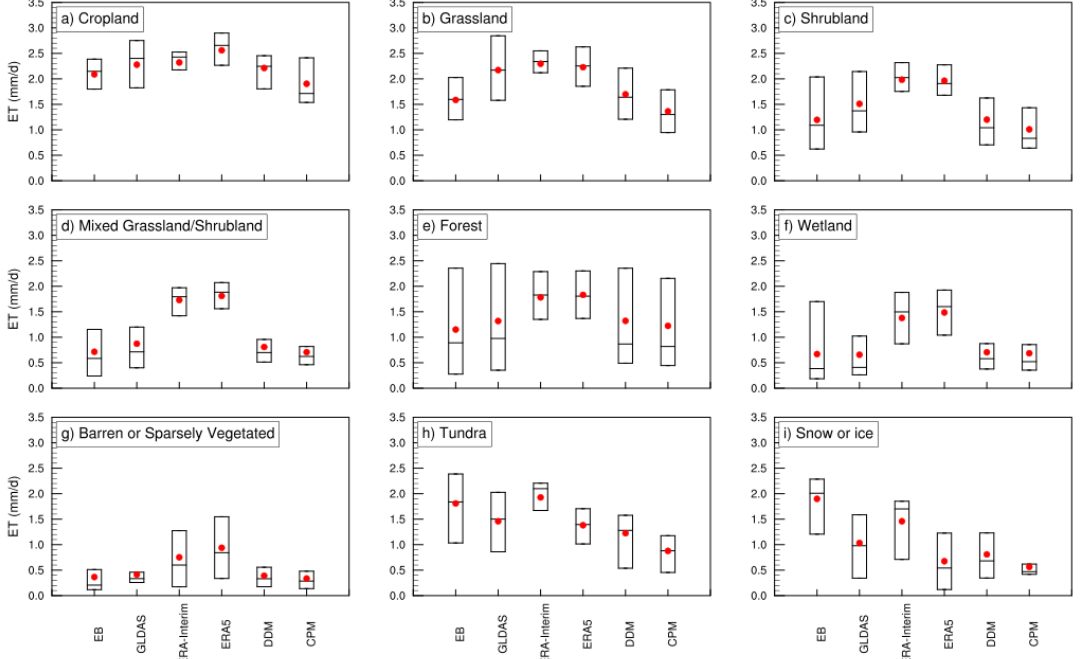
Figure 6. Box-and-whisker plots of ET of nine land-use categories based on six datasets for the monsoon season in 2014: ( a ) cropland; ( b ) grassland; ( c ) shrubland; ( d ) mixed grassland/shrubland; ( e ) forest; ( f ) wetland; ( g ) barren or sparsely vegetated; ( h ) tundra; ( i ) snow or ice (units: mm/d). The top and bottom of each box are the 20th and 80th percentiles in grid cells with the same land-use type. The lines in each box represent the median; red dots represent the mean.